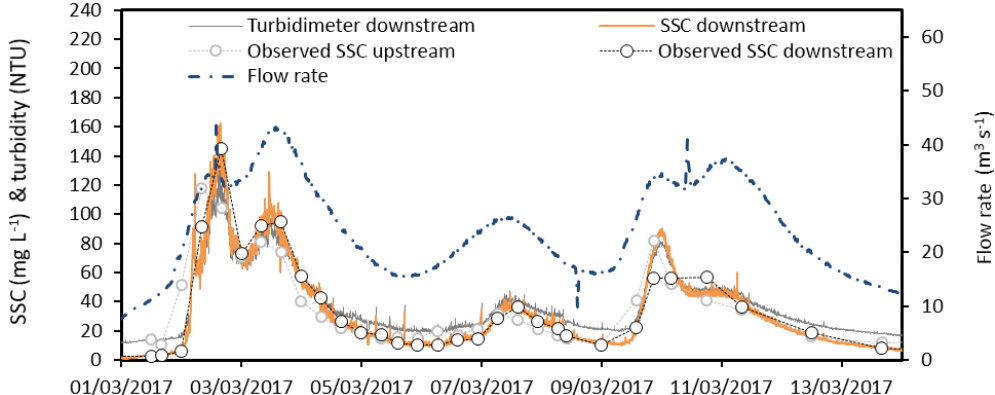
Figure 3. Times series of flow rate, turbidity, and calculated SSC. Punctual SSC measured at the upstream and downstream boundaries of the model domain is also plotted for comparison.